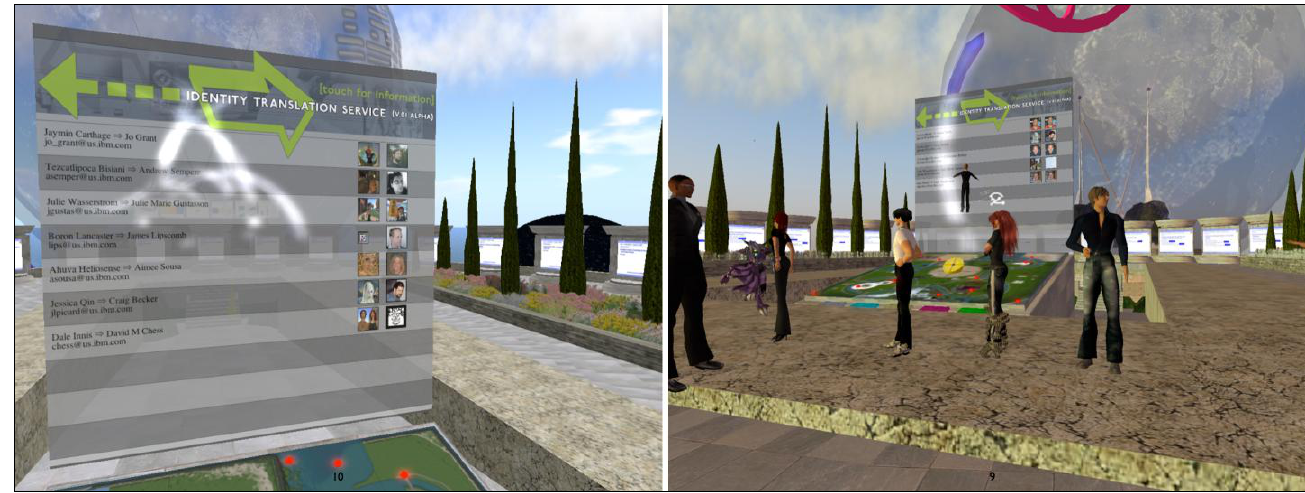
Figure 1. AGM 2008 Identity Translation